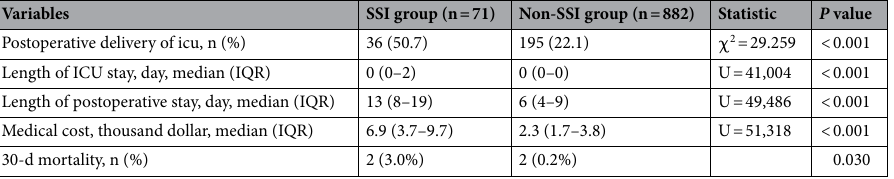
Table 2. Outcomes of included